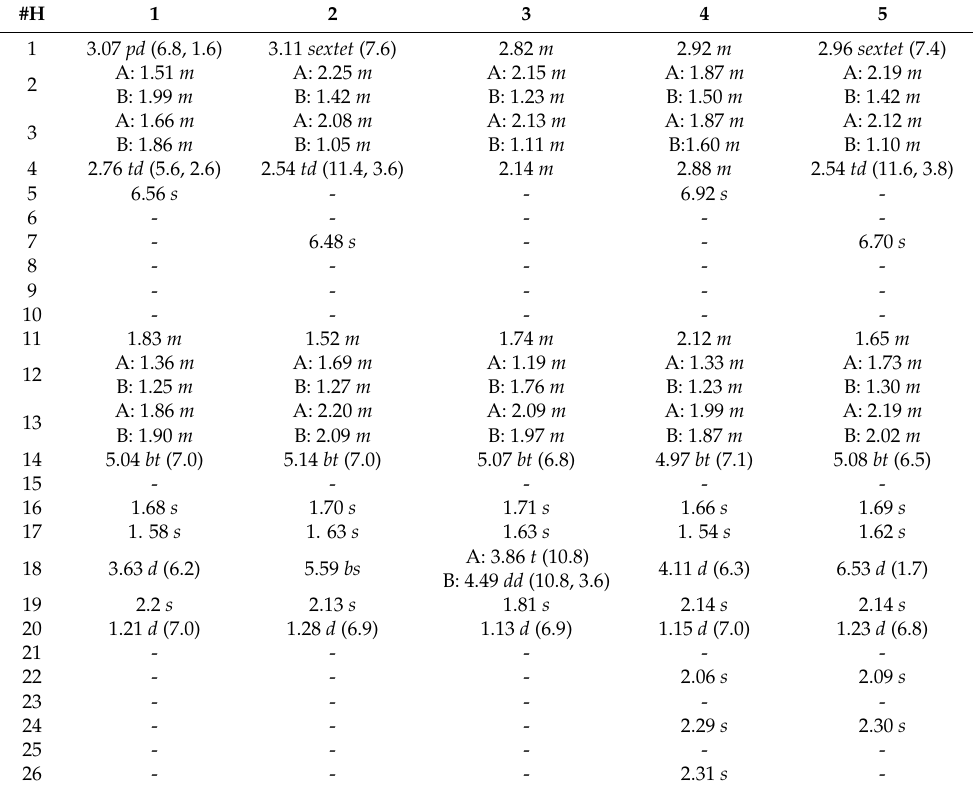
Table 1. 1 H-NMR data for Compounds 1 – 5 (400 MHz, δ in ppm J values (Hz) in parentheses, measured in CDCl 3 relative to tetramethylsilane (TMS)).